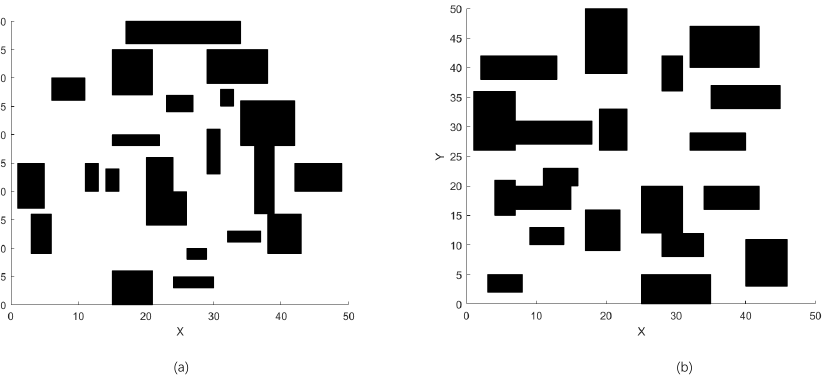
Figure 6. Set of test 50 × 50 maps for the second scenario in which ( a , b ) show the different distribu- tions of obstacles on 50 × 50 maps. Table 3. Convergence performance on 50 × 50 maps.